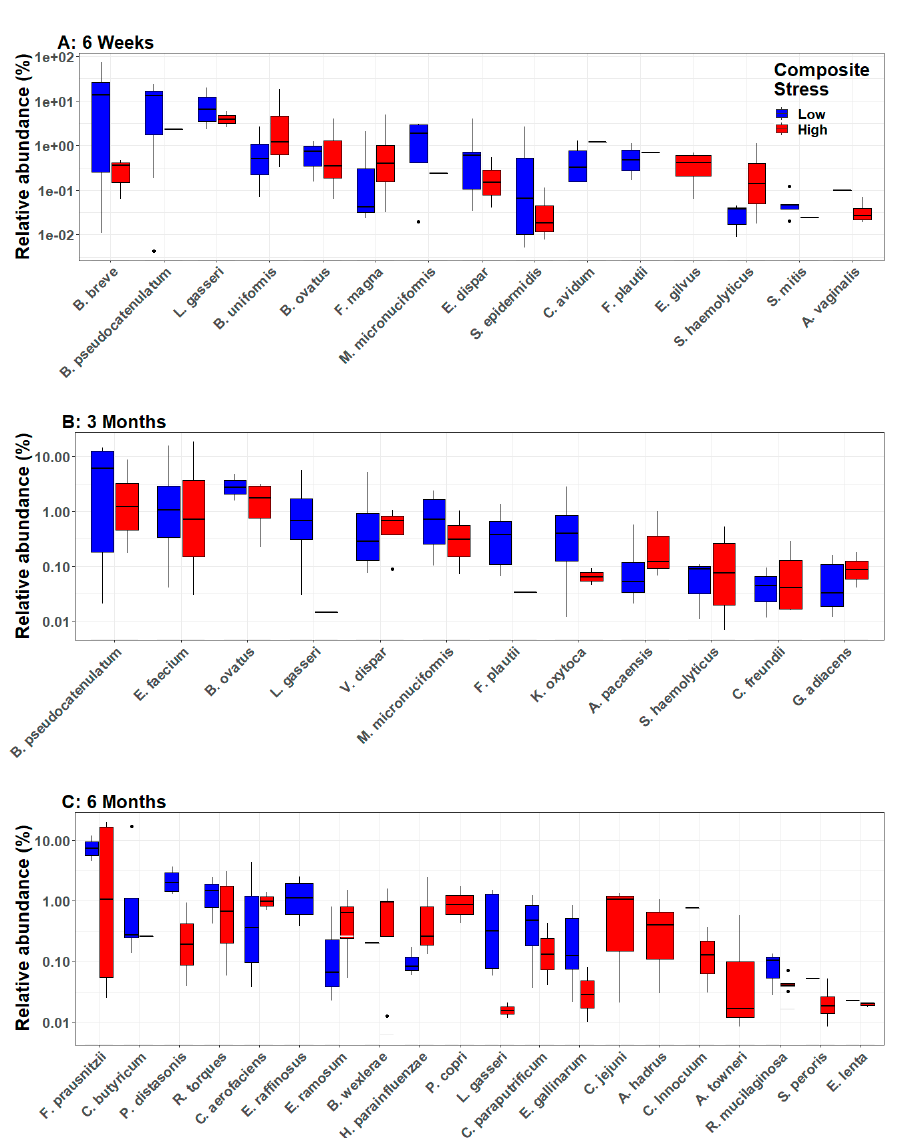
Figure 3. Differential abundance analysis of gut microbiota of infants born to high and low stress mothers. Box plots depict the relative abundance (%) of all bacteria that were significantly differentially abundant, shown for groups of infants of high and low stress mothers. The plots depict % relative abundance on a log scale (individuals with zero relative abundance of a particular taxa are not shown since log (0) is undefined). Analyses controlled for infant sex and antibiotic use, and compared infants of high and low stress mothers at ( A ) six weeks, ( B ) three months, and ( C ) six months.